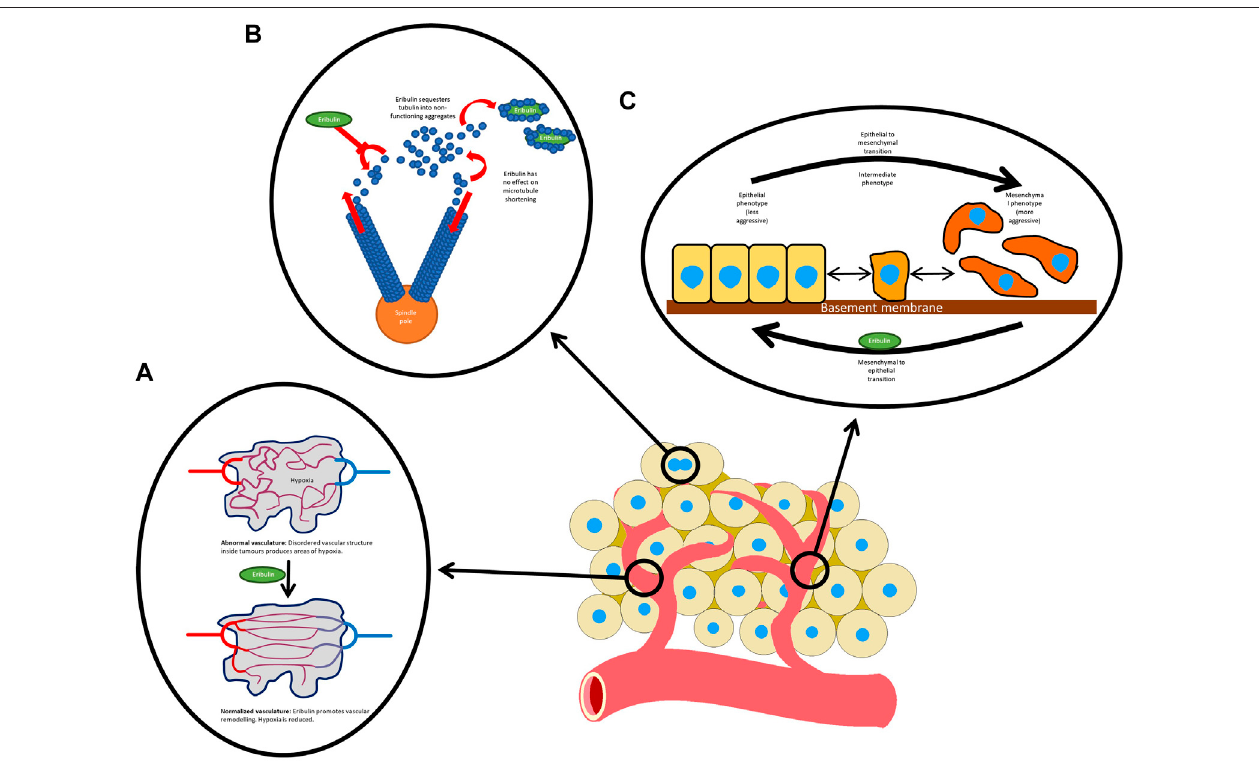
FIGURE 1 | Mechanisms of action of eribulin: (A) normalizes the tumor vasculature; (B) inhibits microtubule growth without having any effect on microtubule shortening. Eribulin also sequesters tubulin, reducing the supply available to microtubules; and (C) reverses the mesenchymal to epithelial transition.